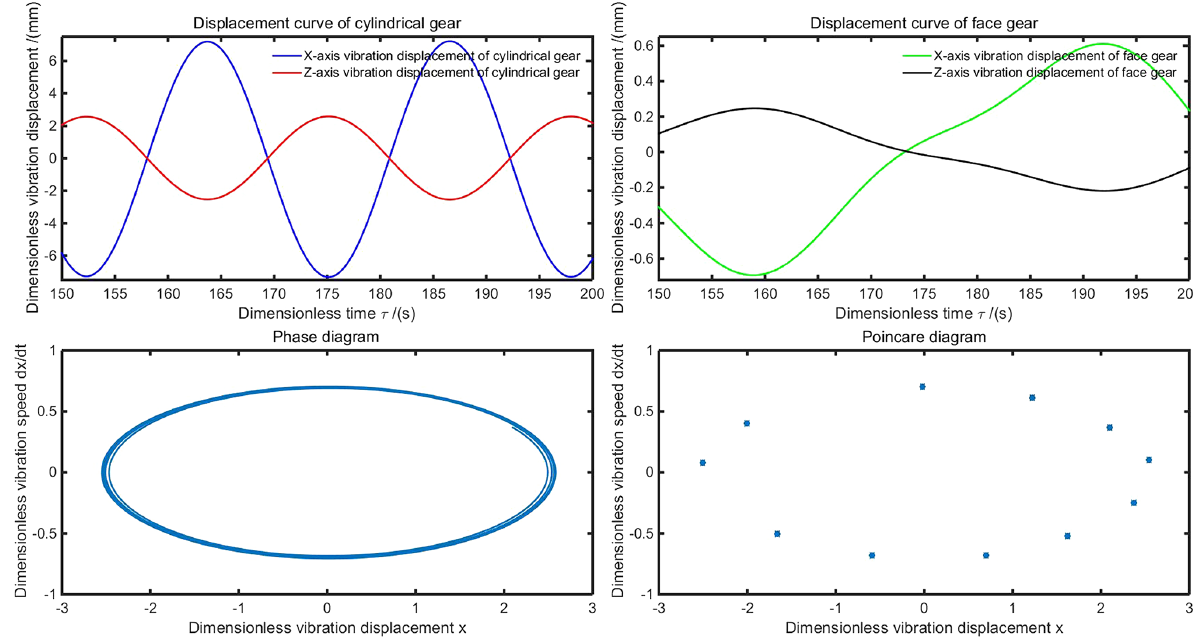
Figure 21. Displacement, phase, and Poincare diagrams of nonlinear system with excitation frequency